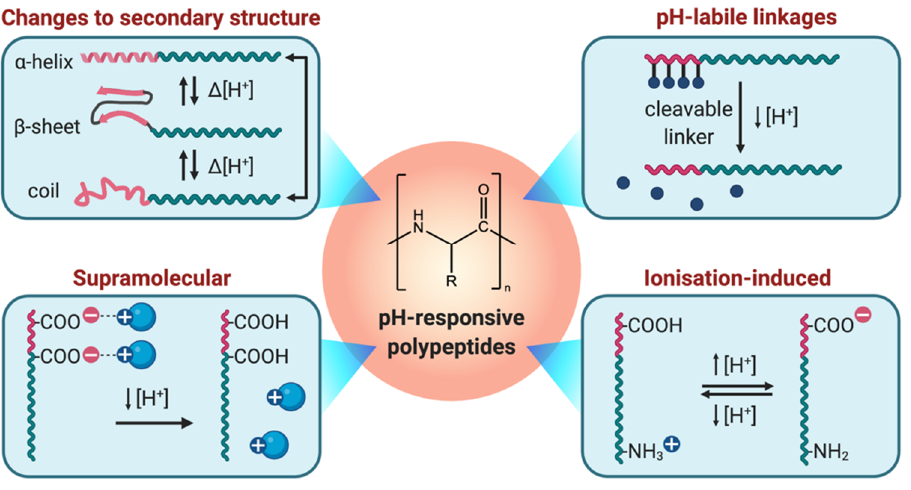
Figure 2. Strategies to prepare pH-responsive polypeptides and polymer-peptide hybrids.